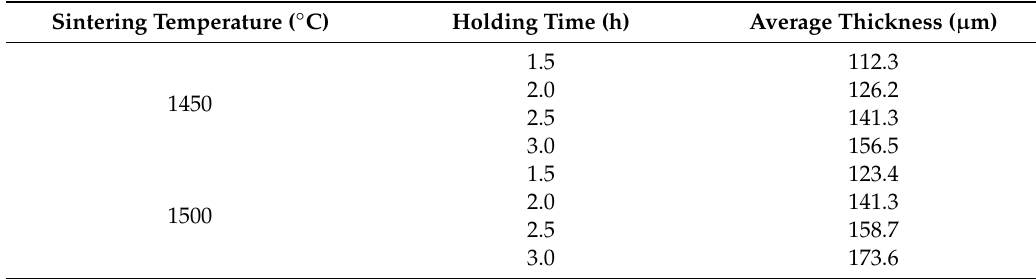
Table 2. Interface reaction layer thickness at different holding time.